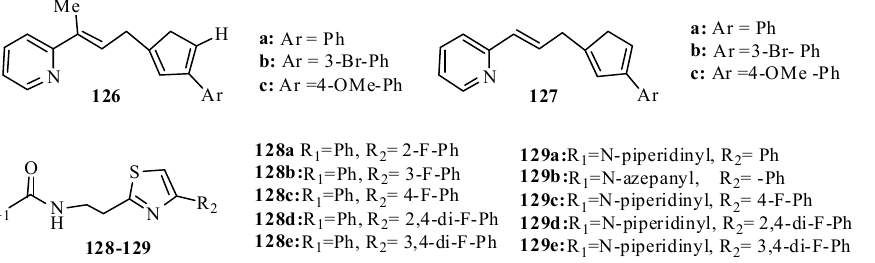
Figure 53. Structures of thiazoacetylpyridines, thiazopyridines ( 126 , 127 ) amide and urea derivatives of thiazol-2-ethylamines ( 128 , 129 ).